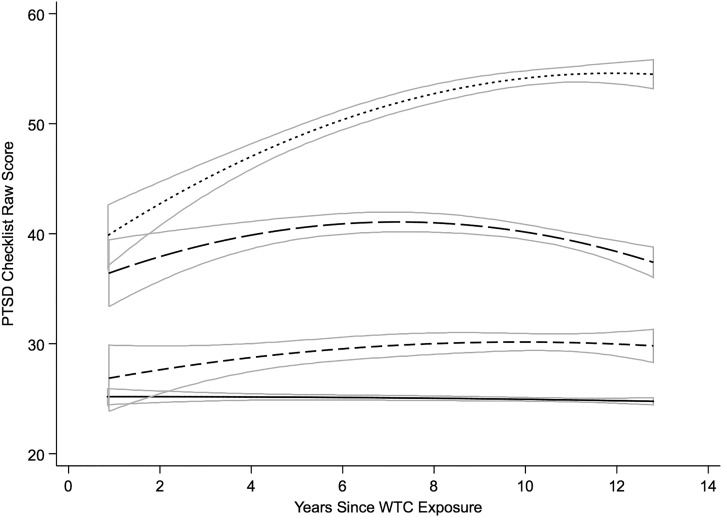
Predicted trajectories derived from longitudinal models of PTSD Checklist data for
responders with no history of World Trade Center (WTC) post-traumatic stress
disorder (PTSD) (––), and partial (- - -), remitted (– – –) and active WTC-PTSD
(· · ·). The boxes outlined in solid gray represent 95% confidence intervals.